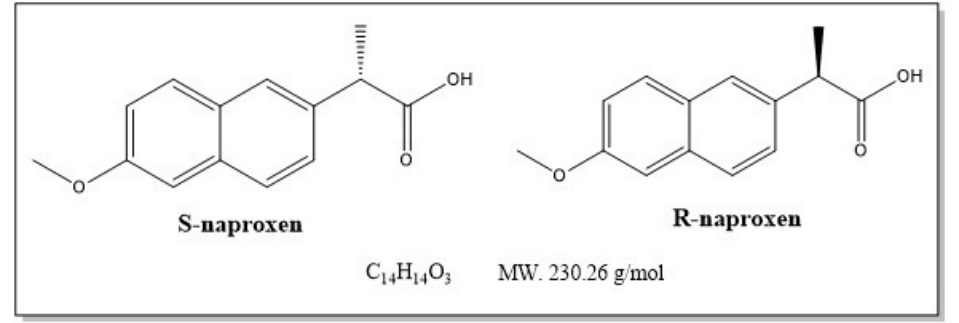
Figure 1. Chemical structures of Naproxen